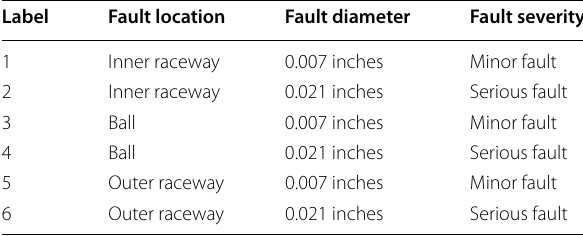
Figure 3 Configuration of the experimental system used by CWRU